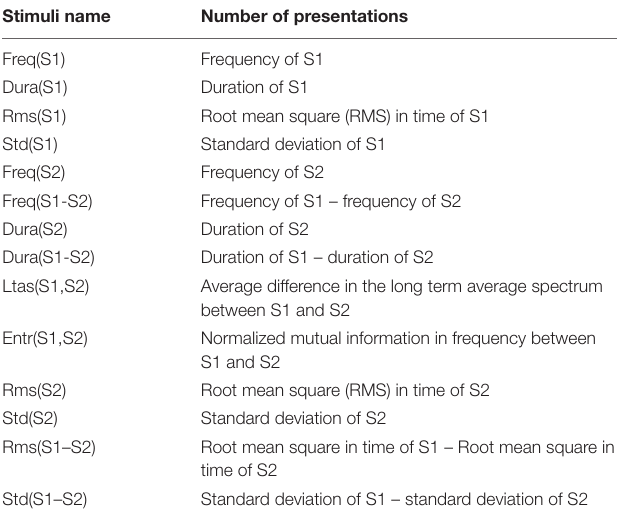
TABLE 4 | Sound properties explored on the events of the